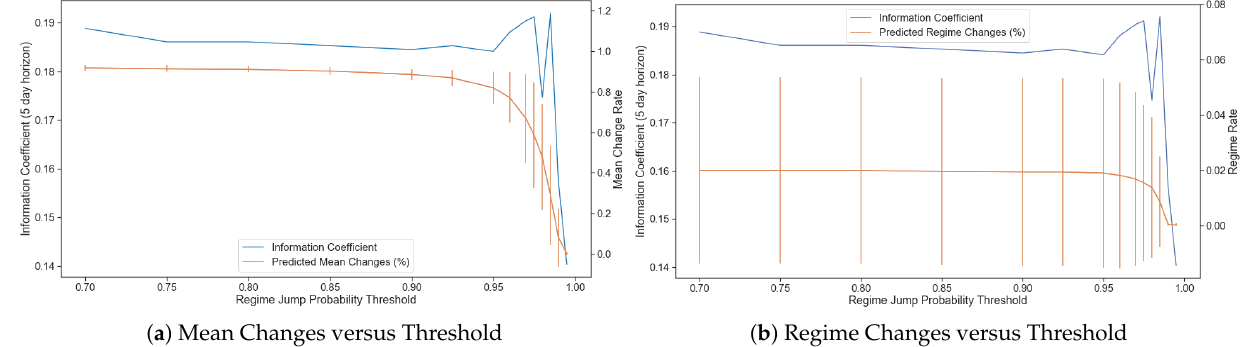
Figure 10. Regime Jump Threshold Effect on